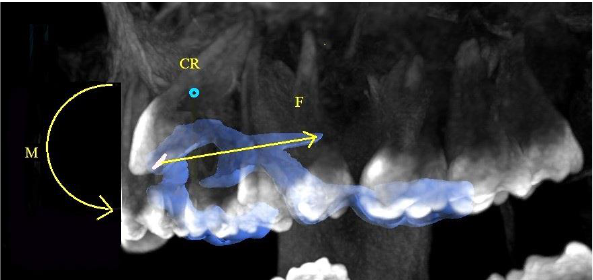
Figure 7. Force (F) delivered to the canine through the device and the corresponding moment (M), since the point of force application on the crown is lower and at distance from the center of resistance (CR) of the canine.